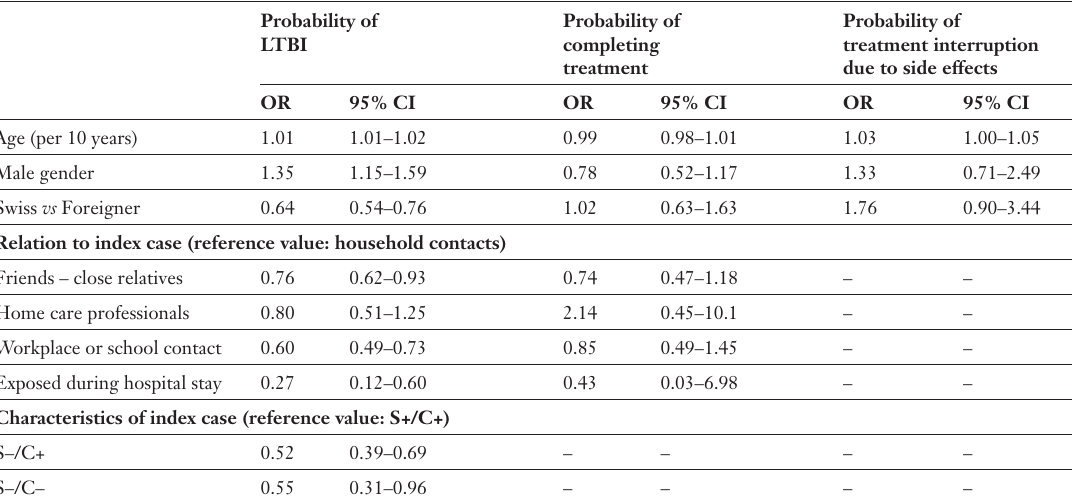
Results of multiple logistic regression models for estimating probability of latent tuberculosis infection (lTBi) in contacts, probability of completing treatment for lTBi, and probability of treatment interruption due to side-effects of treatment for lTBi. OR: odds ratio; 95%Ci: 95% confidence interval. S+: smear positive; S-: smear negative; C+: culture positive; C-: culture negative. Age is expressed per 10 years. Adjusting for clustering was not possible due to lack of information regarding relationship between index cases and contacts in the original database.This may slightly underestimate confidence